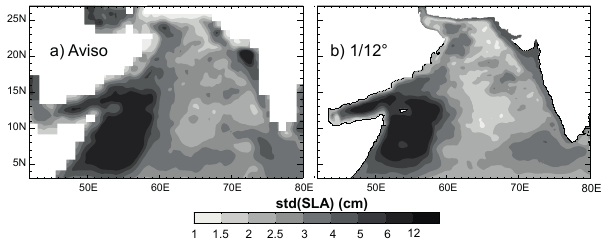
Fig. 3. (a) Mesoscale circulation estimated from the AVISO dataset and (b) in the model at eddy-resolving resolution. The mesoscale circulation is quantified by the standard deviation of the sea level anomaly (SLA) filtered in the 14–120days band, over the 1995–2003period.